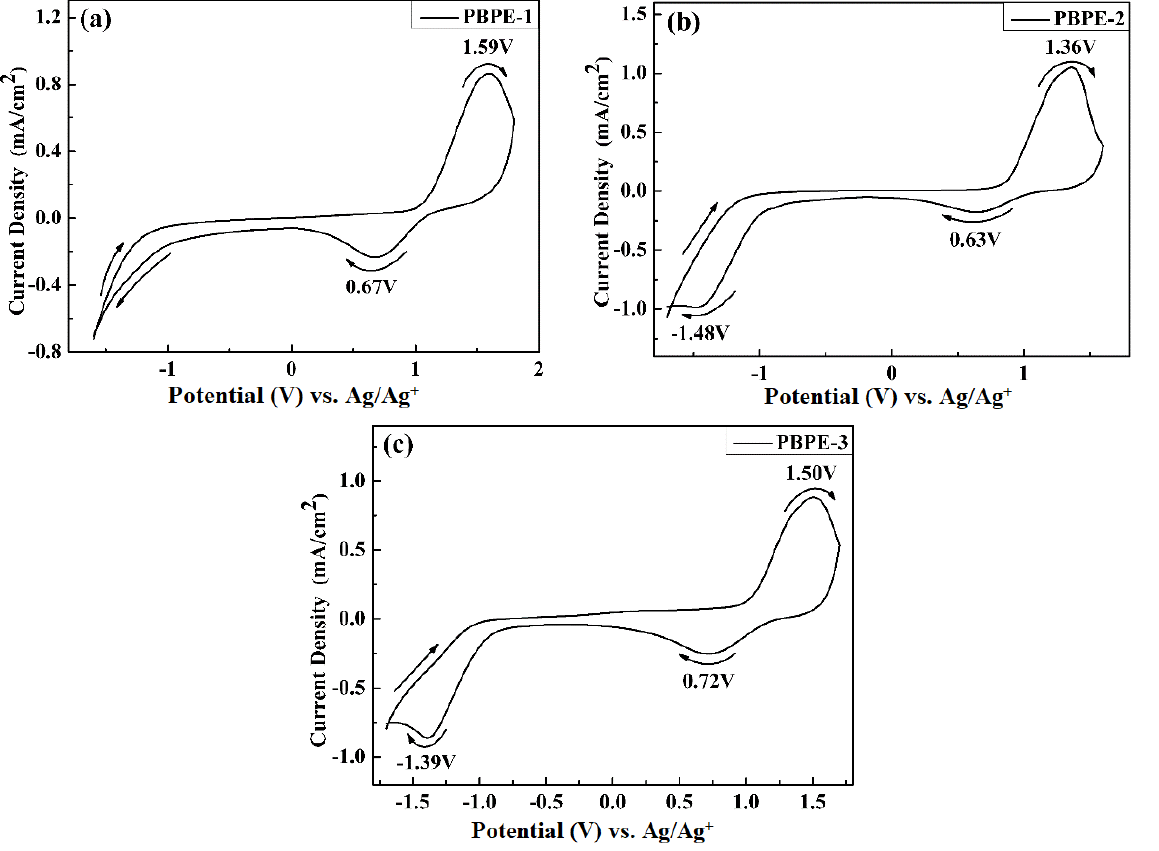
Figure 4. CV curves of copolymer films PBPE-1 ( a ), PBPE-2 ( b ) and PBPE-3 ( c ) on the spray-coated indium tin oxide (ITO) substrates in 0.2 M TBAPF 6 /ACN electrolyte solution at a scan rate of 100 mV/s.